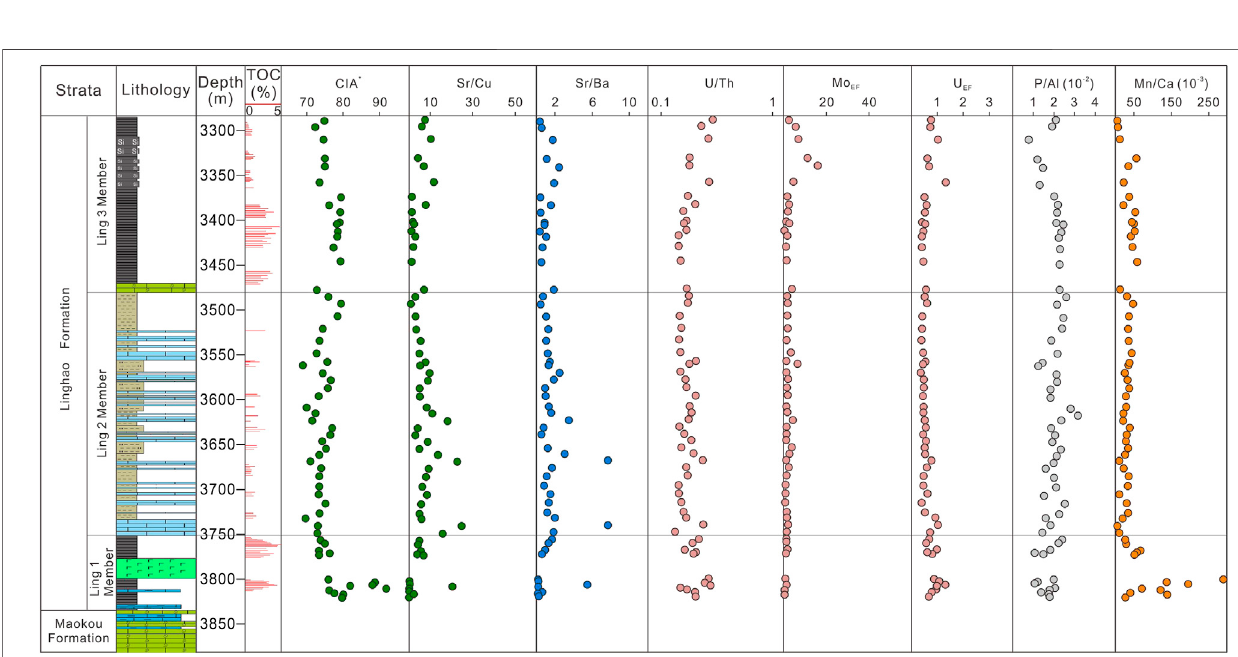
The variation of Sr/Ba is similar to that of Sr/Cu ( Figure 8 ). The Sr/Ba of lower Ling 1 is the lowest, ranging from 0.13 to 5.48, and the average value is only 0.85 ( n = 9). The average Sr/Ba ratios for upper Ling 1, Ling 2, and upper Ling 3 is 1.04 (0.59-1.69, n =